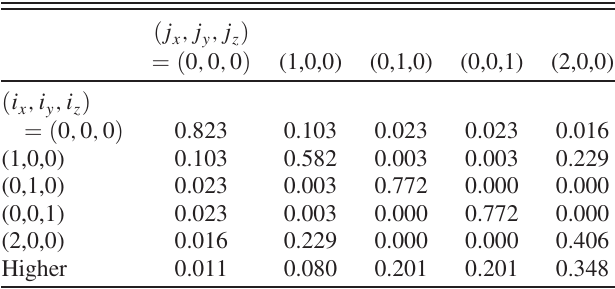
TABLE I. Single-photon excitation probabilities from the ( j j , j )th to the ( i , i , i )th band. The index (0,0,0) refers to the y z x y z ground band, higher indices to the i th ( j th) excited band along the given spatial